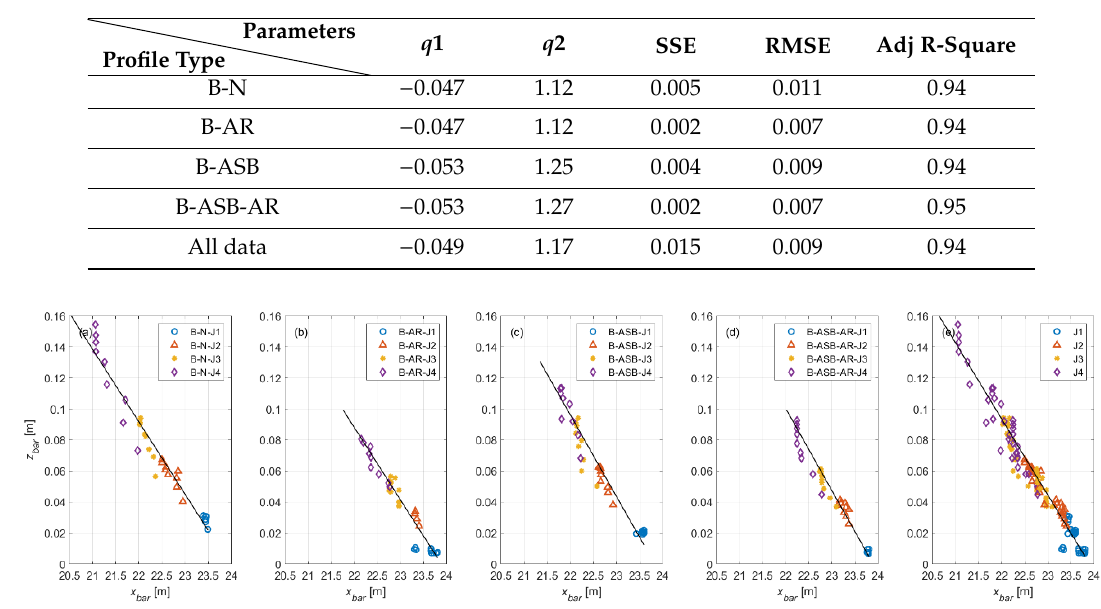
Table 4. Fitting parameters (i.e., dimensionless q1 and q2) with evaluation for linear migration trajectory of breaker bar in di ff erent profile types.